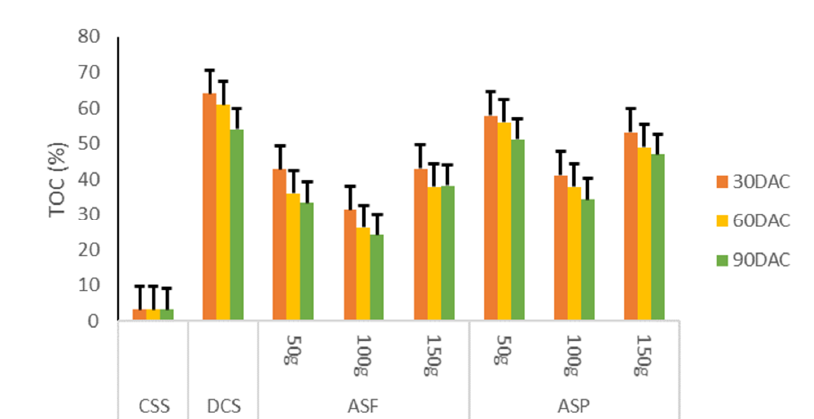
Figure 2. Change in soil TOC levels in diesel contaminated soil during bioremediation analysis Values are means with standard errors. CSS = Control Soil, DCS = Diesel Contaminated Soil, TOC = Total Organic Carbon, ASF = Amended Soil with Fresh E. crassipes, ASP = Amended Soil with Powdered E. crassipes , DAC= Days After Contamination.